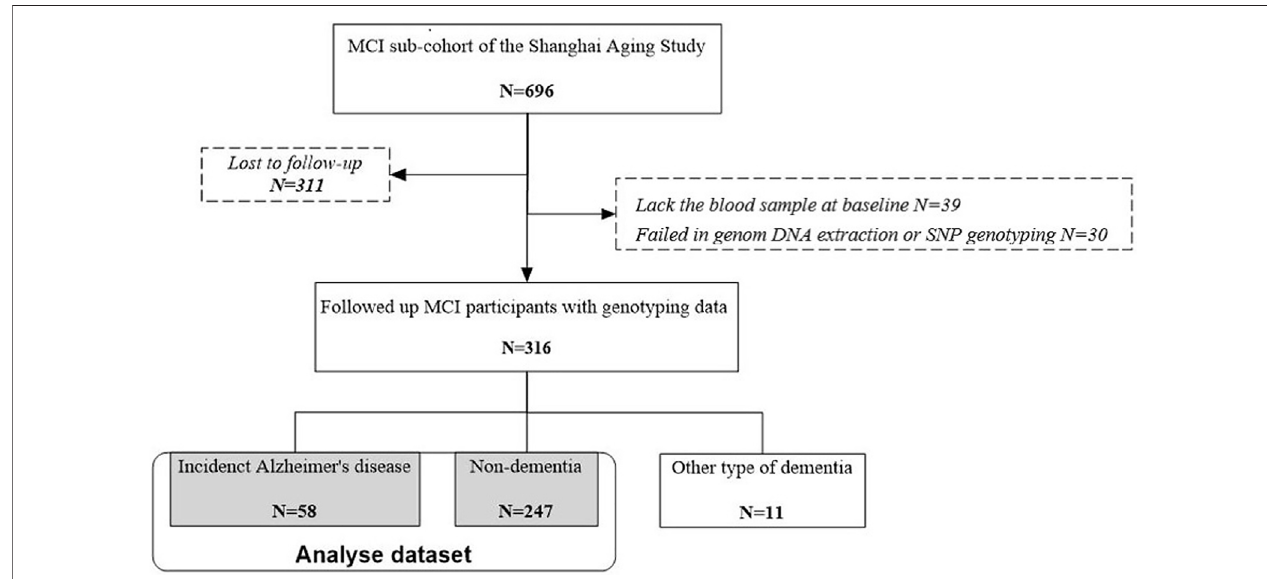
FIGURE 1 | Flow chart of participant recruitment for the present study. MCI, mild cognitive